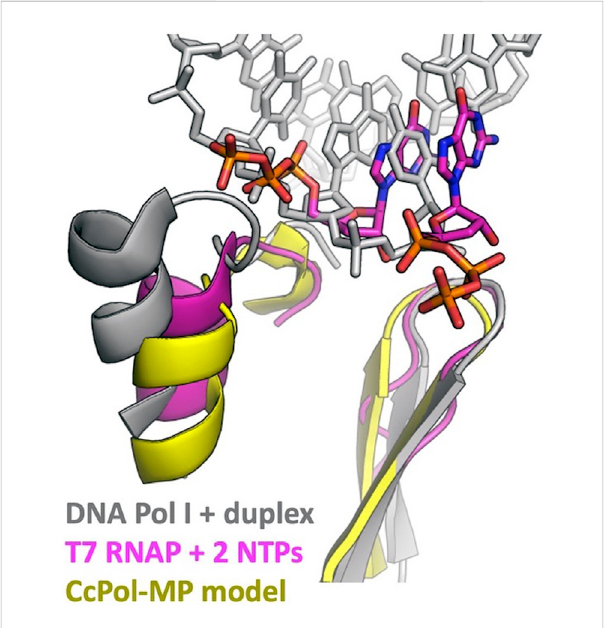
FIGURE 5 DNA Pol I may block the initial triphosphate. The last helix in the thumb and the central beta hairpin of the palm subdomains are shown. This superposition suggests that an initial triphosphate might makesteric clashes with thelast helix of thethumbof DNAPol I ’ s helix (and/or the turn leading into that helix). That helix is shorter in T7 RNA polymerase and in all the full-polymerase models reported here. The Pol I coordinates were taken from PDBid 1l5u (Johnson et al., 2003) and the T7 RNAP coordinates from 2pi4 (Kennedy et al.,